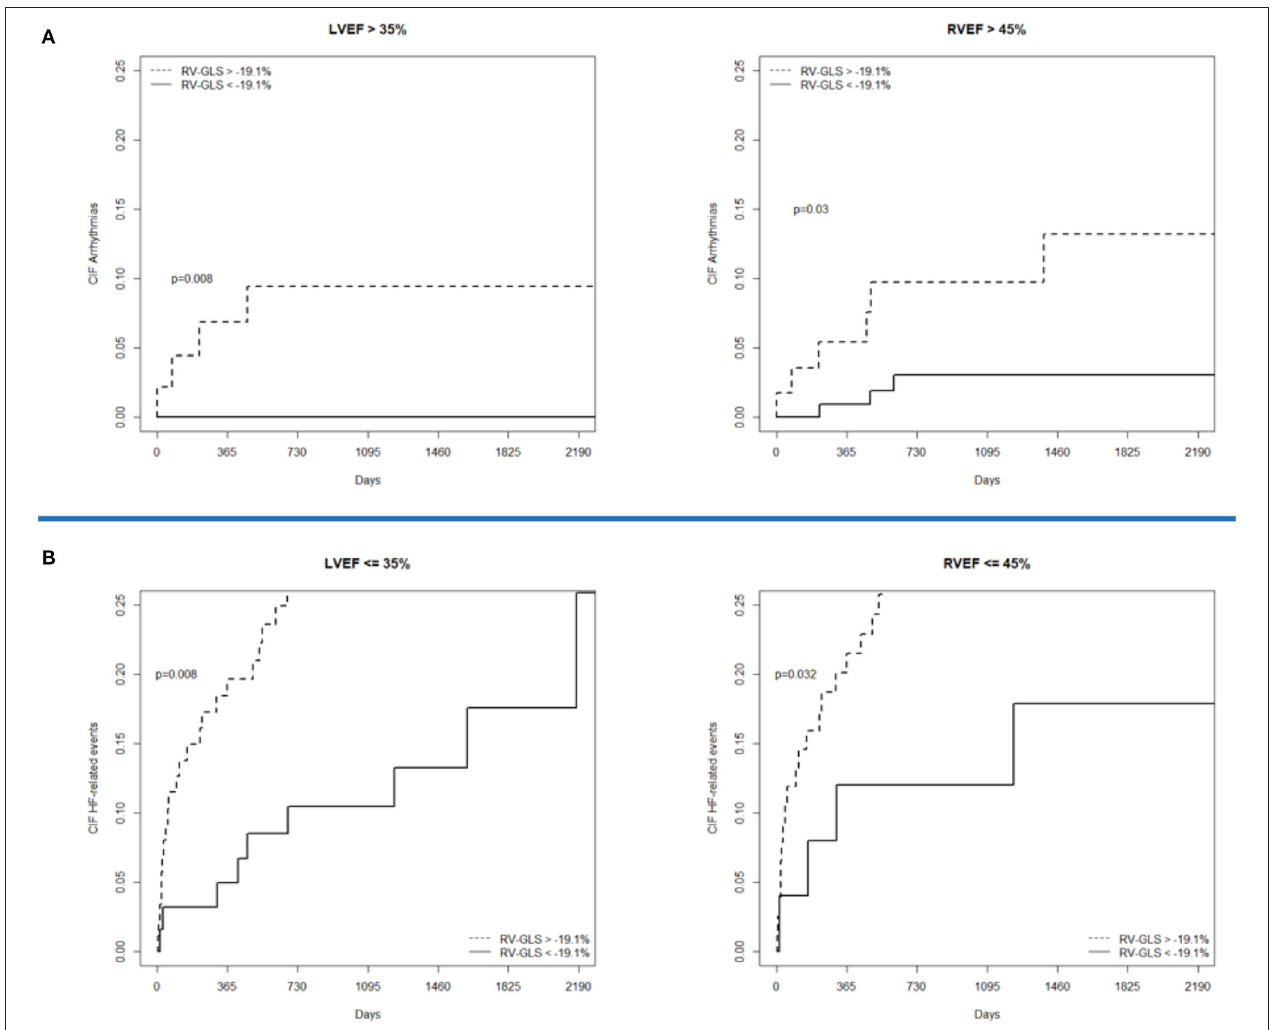
FIGURE 6 | Cumulative incidence curves showing the association of RV-GLS in secondary endpoints such as life-threatening arrhythmia-related events and HF-related events after stratification for LVEF and RVEF. In (A) RV-GLS discriminates patients at risk of arrhythmic events in those with LVEF and RVEF are not severely depressed whereas, in (B) discriminates patients at risk of HF related events (including HF hospitalizations) in those with severe reduction of EF, both left and right. HF, heart failure; LVEF, left ventricular ejection fraction; RVEF, right ventricular ejection fraction; RV-GLS, right ventricular global longitudinal